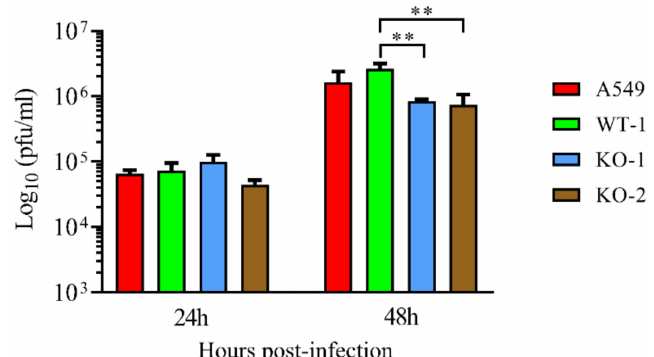
Figure 5. Human respiratory syncytial virus titers in the supernatant of A20 KO cells. Cells were infected at a MOI of 3. Supernatants were collected at 24 and 48 hpi and the virus was titrated by plaque assay. Data are represented as the mean and standard deviation from three independent experiments. Statistically significant di ff erences between indicated cell lines were determined by the t -test. From the p values obtained, FDRs were calculated: ** q-value < 0.01. KO-1 and KO-2, A549 cell lines that do not express A20. WT-1, wild-type A549 cell line obtained following the same process as with KO-1 and KO-2.